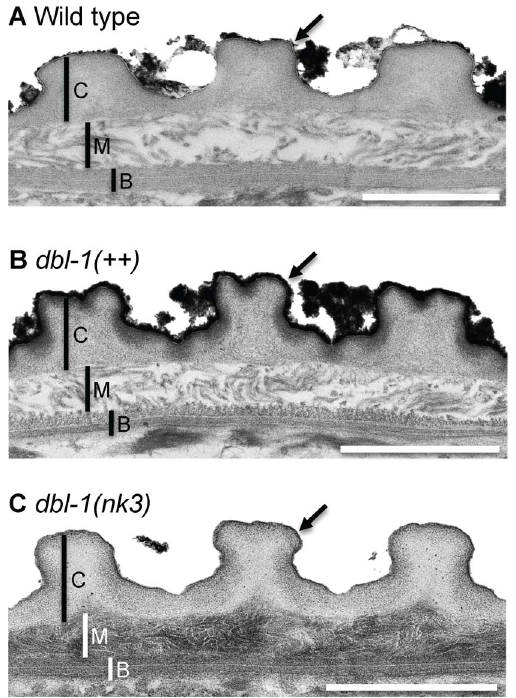
Figure 5. The DBL-1 pathway regulates cuticular organization and composition. Transmission electron microscopy (TEM) micro- graphs of wild-type (A), dbl-1( ++ ) (B), and dbl-1(nk3) (C) animals. C indicates cortical layer; M indicates medial layer; B indicates basal layer; and the arrow marks the surface coat and epicuticular layer. Scale bars=1 m m.